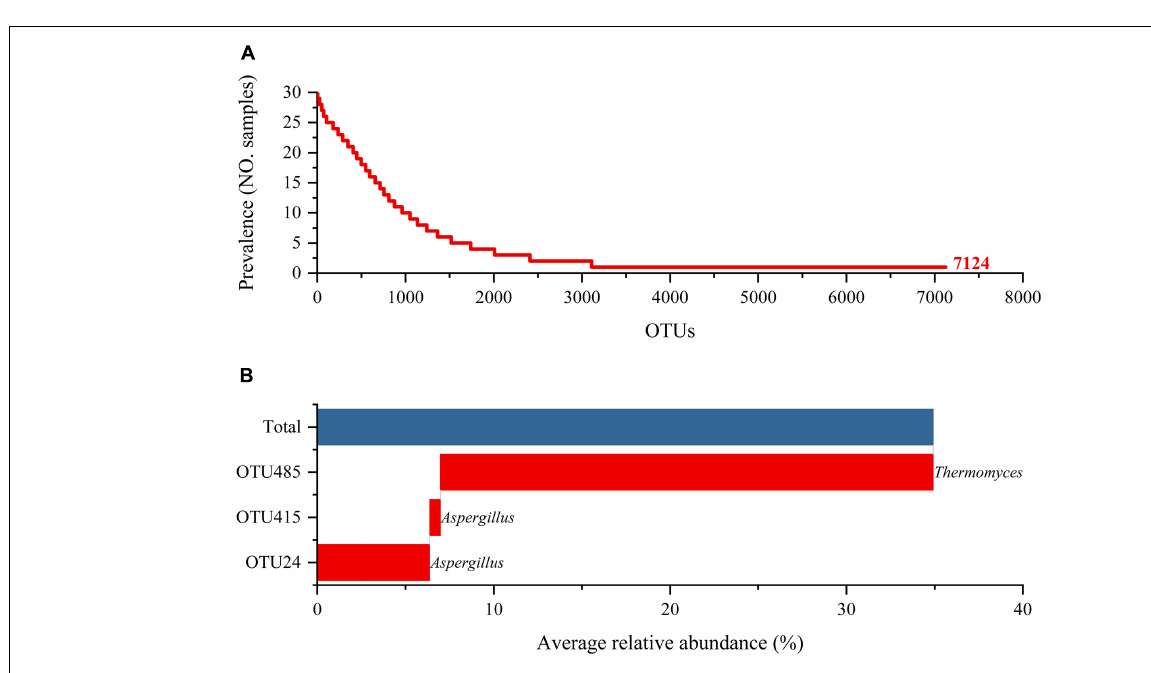
FIGURE 2 | Fungal composition of HTD samples at the level of phylum (A) and genus (B) .